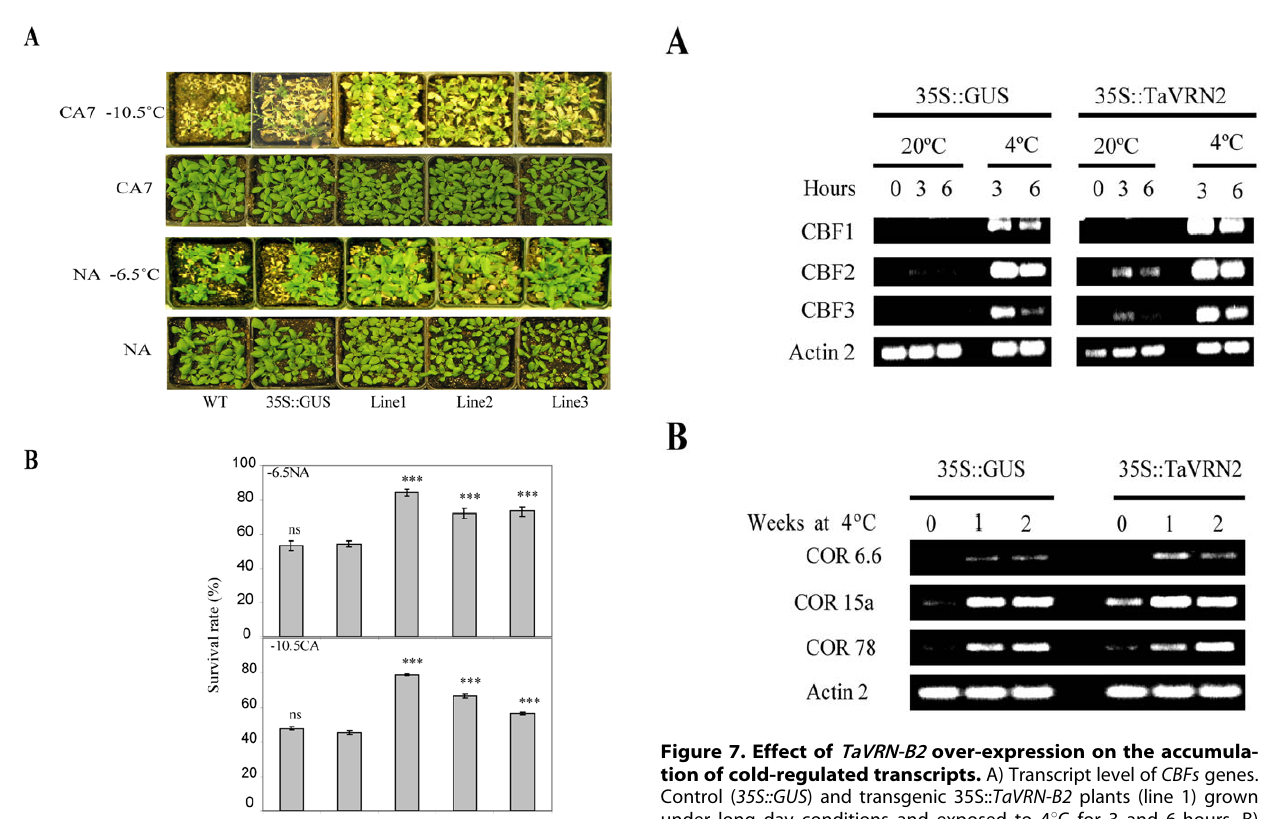
region. Down regulation of the flowering repressor TaVRN2 under